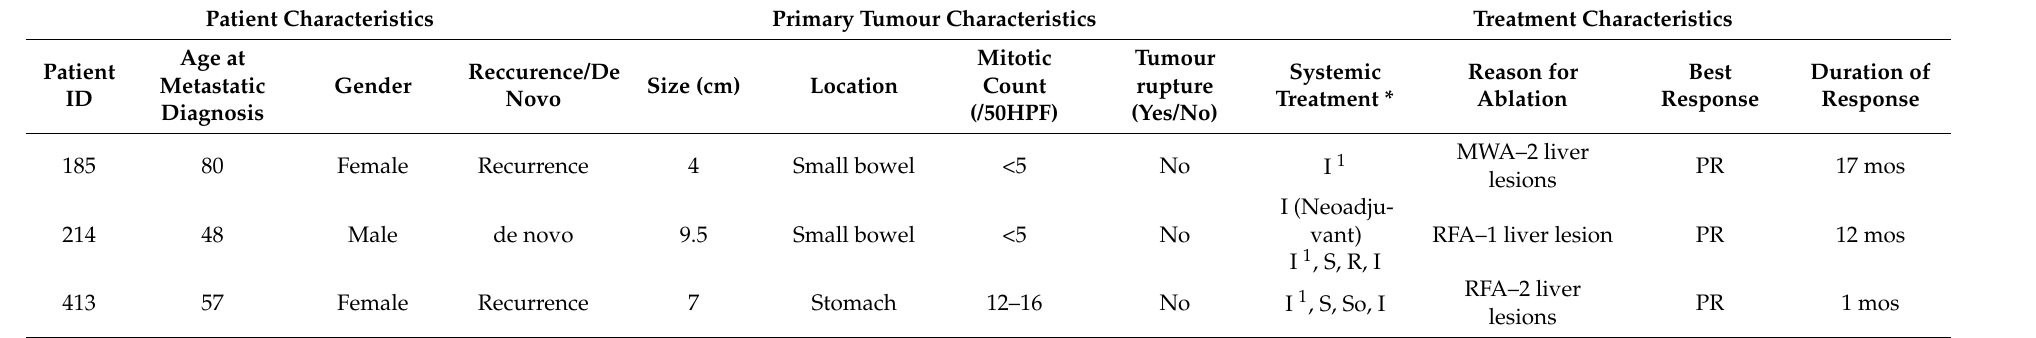
Table 3. Clinical characteristics and outcome of metastatic gastrointestinal stromal tumor (GIST) patients who underwent local